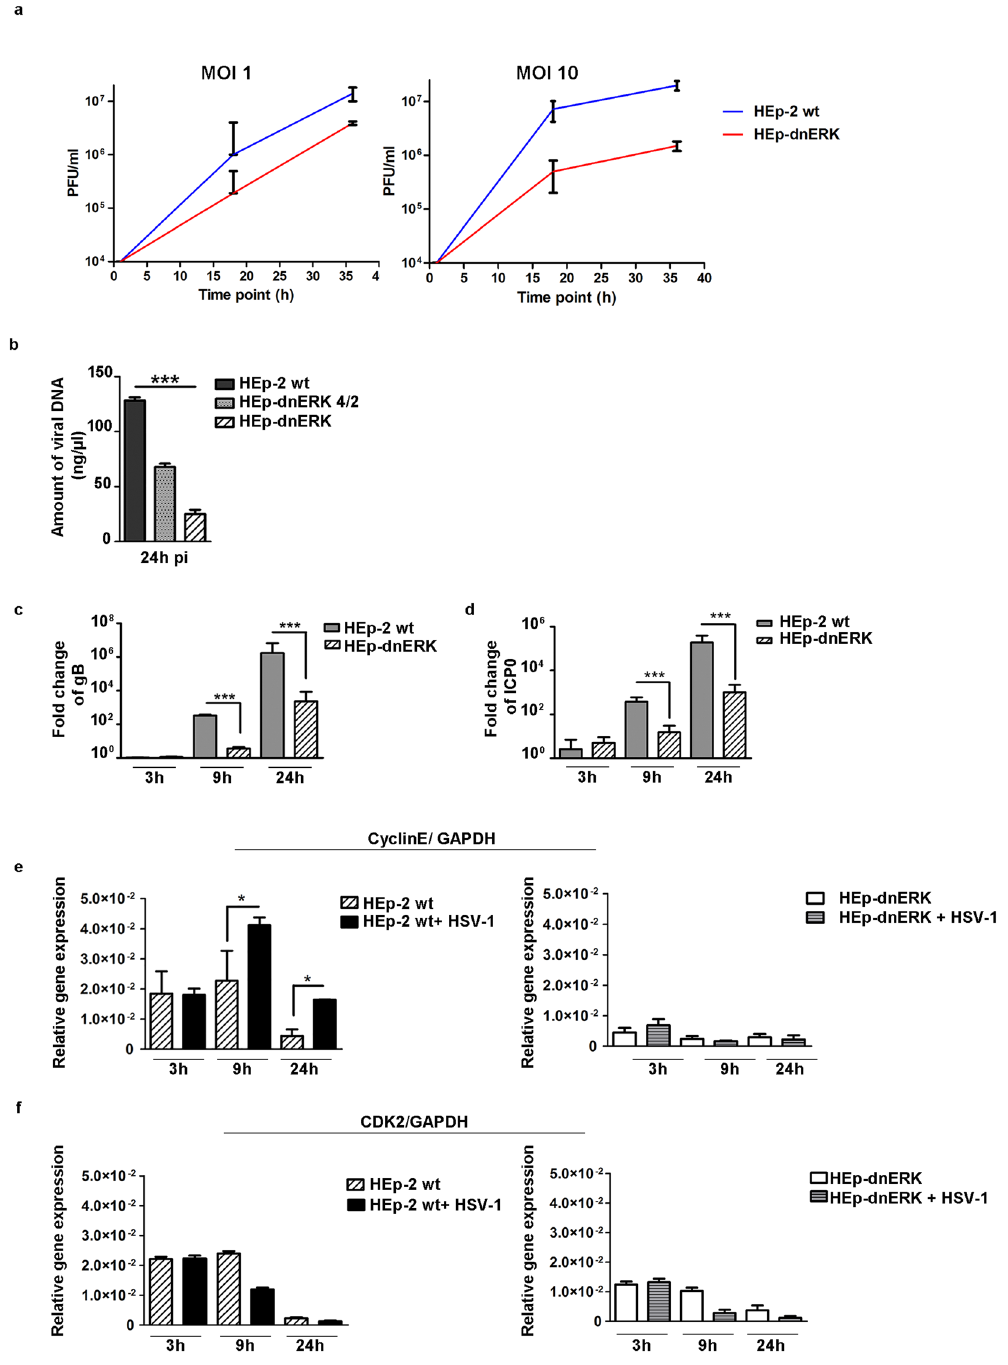
Figure 5. Effect of modulated ERK pathway on HSV-1 replication. ( a ) MOI-dependent growth curves were obtained by infecting HEp-2 and HEp-dnERK with HSV-1 at MOI 1 and 10. The sample were harvested at 1 h, 18 h and 36 h pi, the virus yields were measured by standard plaque assay on Vero cells. The procedure was described in Methods. ( b ) HEp-2, HEp-dnERK and HEp-dnERK 4/2 cell lines were infected with HSV-1 at MOI 10 and collected 24 h pi. The viral DNA was extracted 24 h post HSV-1 infection as described in the Methods. Viral DNA amounts were determined by absolute real-time PCR using a TaqMan probe. The result is expressed as concentration in ng of DNA/ µ l. ( c–f ) Quantitative Real-Time PCR of gB, ICP0, CyclinE and CDK2 transcripts in HEp-2 and HEp-dnERK cells were evaluated at 3 h, 9 h, 24 h pi. Calculations of the copies number were based on external standards and all transcripts were normalized against the GAPDH copies number. Statistical analyses were performed with one-way ANOVA analysis assay in triplicate and * P ≤ 0.05, ** P < 0.01 *** P < 0.001 indicate significant